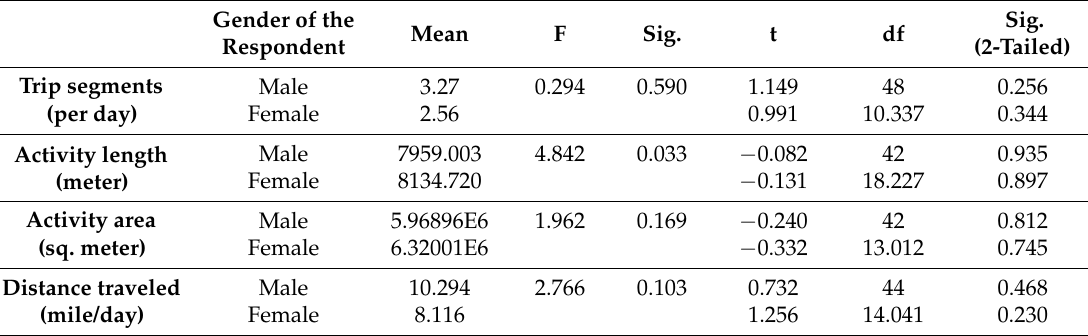
Table 2. Gender-wise independent sample T-test results. Df: degree of